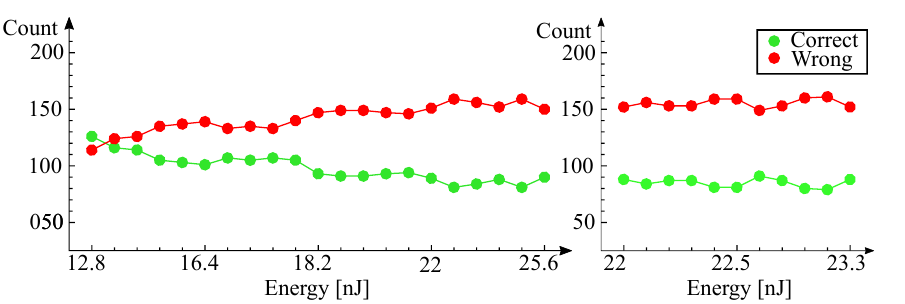
Figure 7: Number of observed faults in the unprotected implementation in function of a rising energy level of laser shots using a spot size of 28